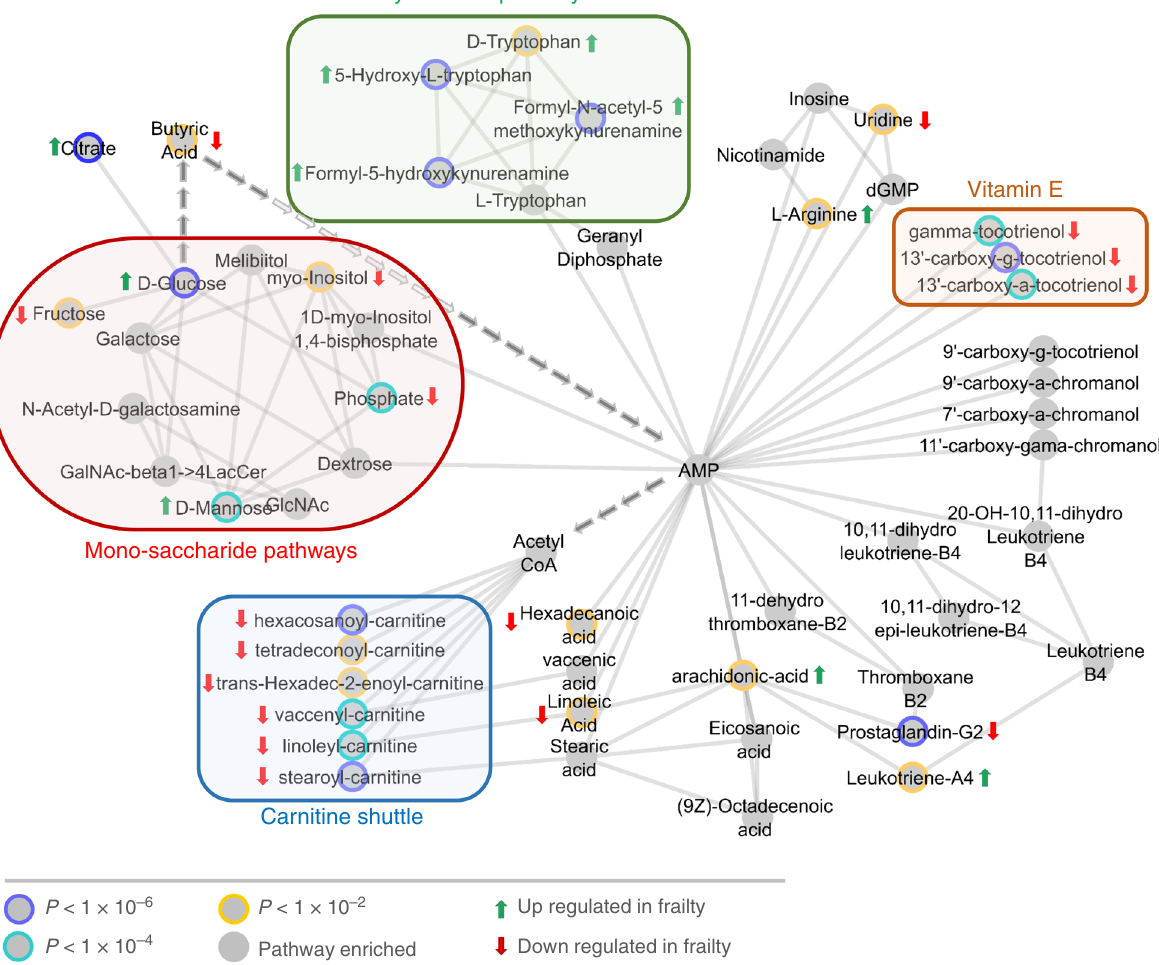
Fig. 4 Enriched pathway model from hybrid network analysis. Frailty metabolite subnetwork generated from the human metabolite network from within the mummichog-Cytoscape pipeline using 554 metabolite features with unique m/z values from the LCMS ( + ) analysis alongside the addition of 86 metabolites from GCMS analysis. This combined approach highlights 4 main metabolic areas that altered within the frailty metabotype, all of them identifying cyclic AMP as a potential hub-metabolite. Source data are provided as a Source Data fi